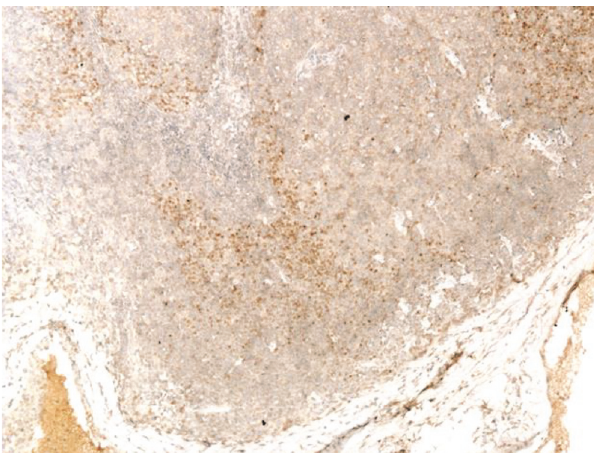
Figure 5: Mantle cell lymphoma (100x). Positive staining with CD5.